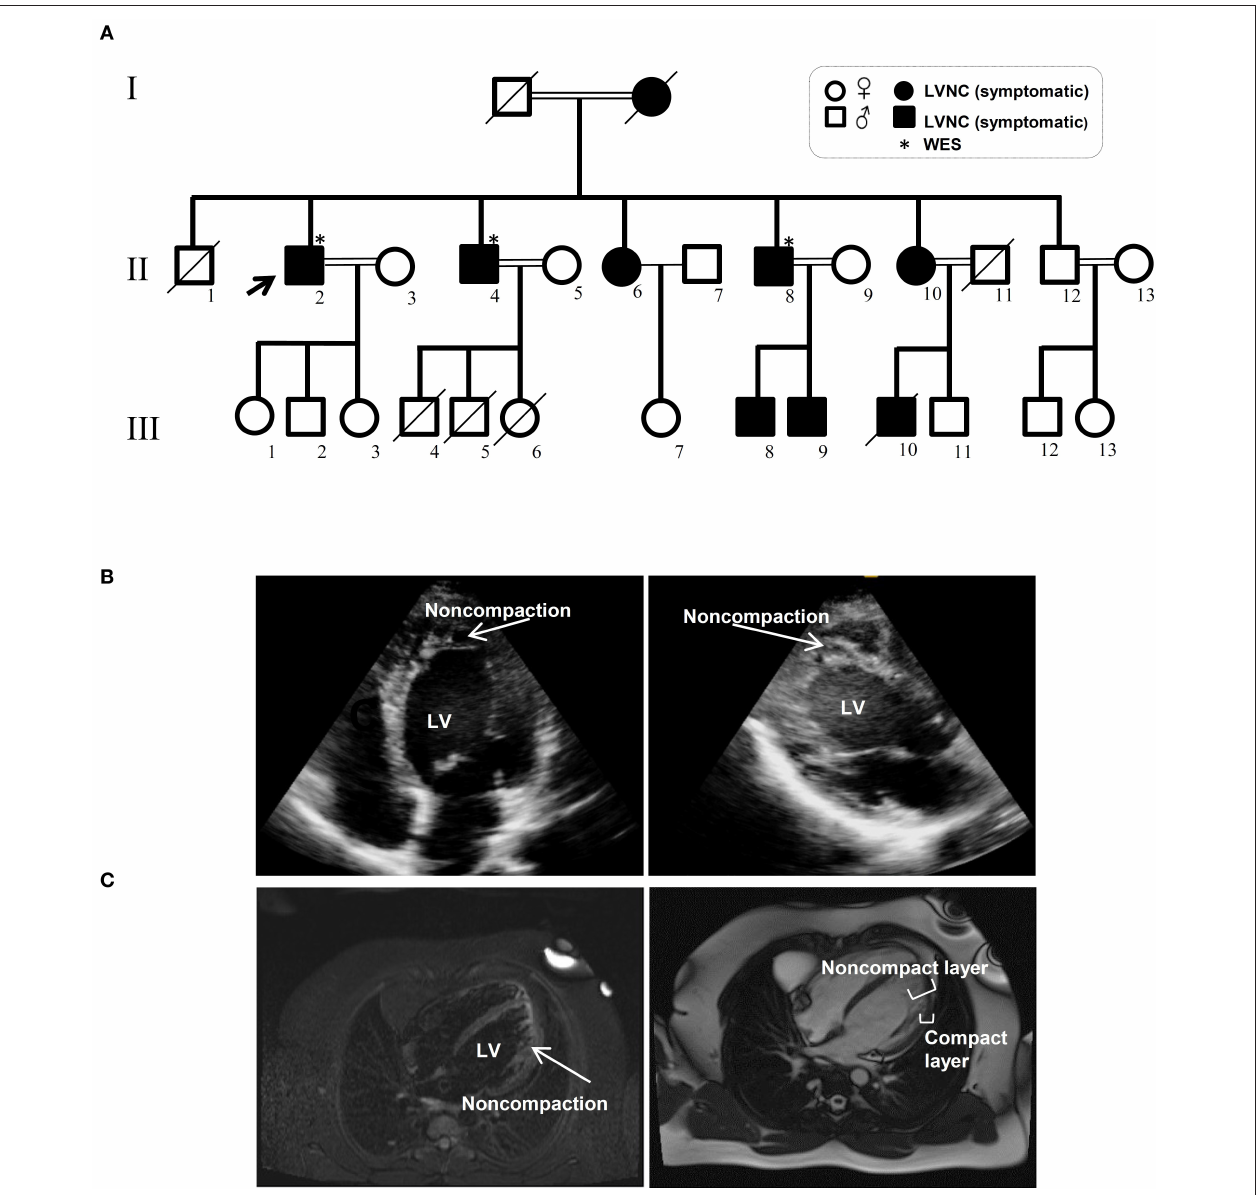
FIGURE 1 | Pedigree and clinical manifestation of the left ventricular non-compaction (LVNC) in the affected members included in this study. (A) A pedigree of the family shows the number of affected members (affected members: shaded, WT: unshaded). A black arrow indicates the proband. Genotypes for the proband and all other family members are shown. (B) Echocardiograph (ECG) images of affected individuals with LVNC of the myocardium. (C) Magnetic resonance imaging (MRI) of thin epicardial and trabeculated endocardial layers of the ventricular